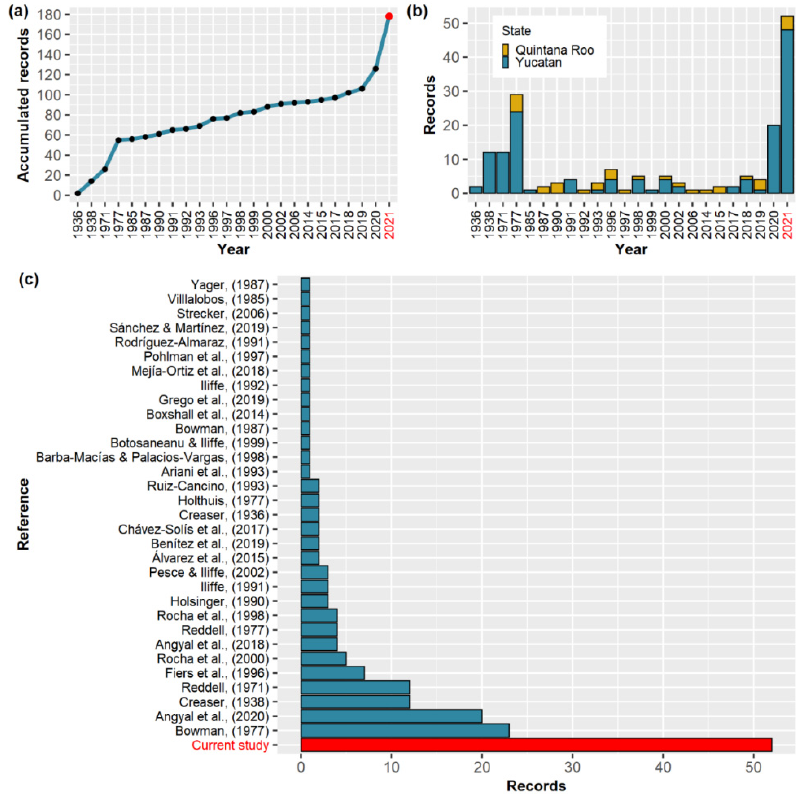
Figure 4. ( a ) Number of accumulated A. cenotensis records per year since species description filtered from duplicates and cross-referencing (see PRISMA statements from Figure S1 and Figure S2). ( b ) Number of A. cenotensis records per year in the Yucatan Peninsula. ( c ) Author record contribution ordered according to contribution frequency. Red color indicates present study results. Main record contributors [37,41] are found in the Reference column from Table 1 along with others. Locations for each record are summarized in Table 1. A map with the recorded locations can be visualized in Figure 5.